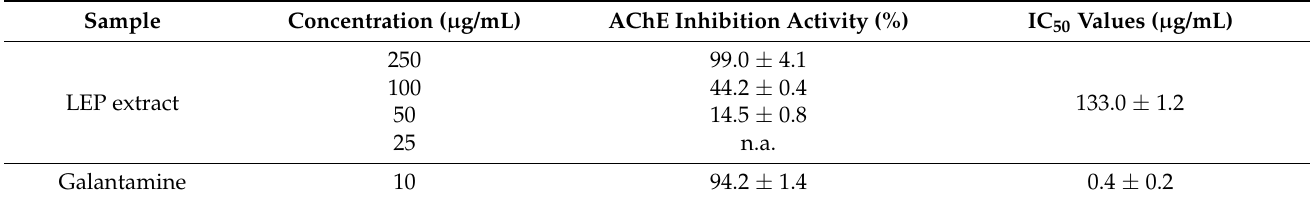
Figure 2. Antifungal activity of the LEP extract. Bars with different letters indicate mean values significantly different at p < 0.05, according to a one ‐ way ANOVA combined with Tukey’s post ‐ hoc test. Data are expressed as the mean of three replicates ± SD. Table 1. Anti-acetylcholinesterase